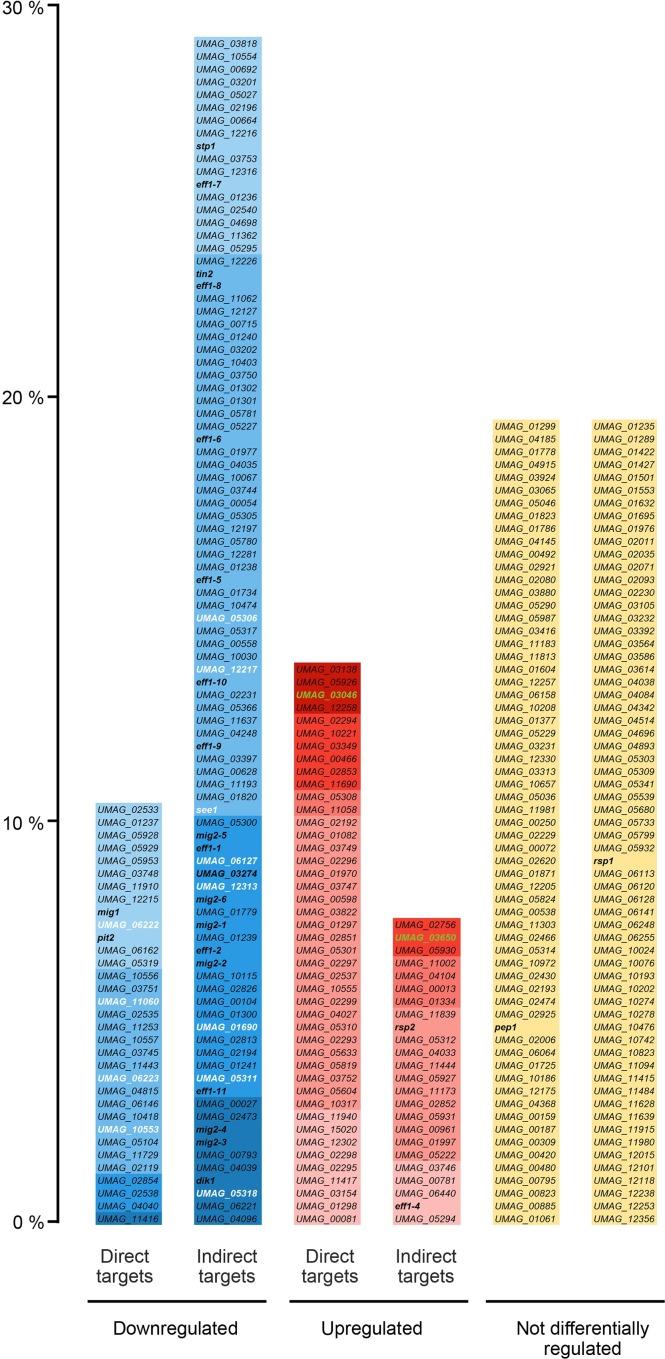
Ros1 alters the expression of the effector repertoire late during infection.All genes encoding secreted effectors without predicted functional domain are listed and their up regulation or downregulation by Ros1 is indicated. Based on the RNA-seq data comparing gene expression in FB1 x FB2 and the corresponding ros1 deletion strains 8 days after infection of maize seedlings and the ChIP-seq data from FB1Δros1-Ros1HA x FB2Δros1-Ros1HA at the same time point, effector genes were sorted in 5 different categories presented as histograms: directly downregulated, indirectly downregulated, directly upregulated, indirectly upregulated and not differentially regulated by Ros1. The percentage (Y axis) represented by each category is calculated relative to the total number of effector genes without functional domains (320 genes based on [47] and secretion prediction by SignalP 4.1 [48]). Colors refer to the fold change of transcripts in wild type compared to ros1 deletion strains in the RNA-seq analysis; the darker the color the higher the fold change. Downregulated effector genes are indicated in blue, upregulated effector genes are indicated in red, effector genes not regulated by Ros1 are indicated in yellow. All genes names or identification numbers are listed; genes which have been characterized or mentioned in previous publications are indicated in bold characters. Leaf-specific effector genes without functional domains [13] showing virulence defects after seedling infection are shown in white, tassel-specific effector genes without functional domains [13] are shown in green. cmu1 [8] and three other differentially regulated effector genes (UMAG_03615 [10], UMAG_11763, UMAG_01130 [13]) are not included in this figure as they contain a functional domain.